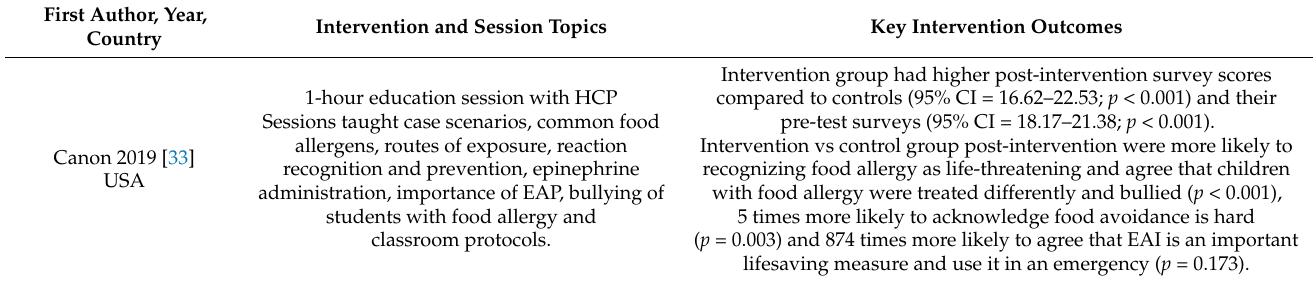
Table 3. Summary of studies that provided educational interventions ( n = 8), presented in alphabetical order by first author’s last